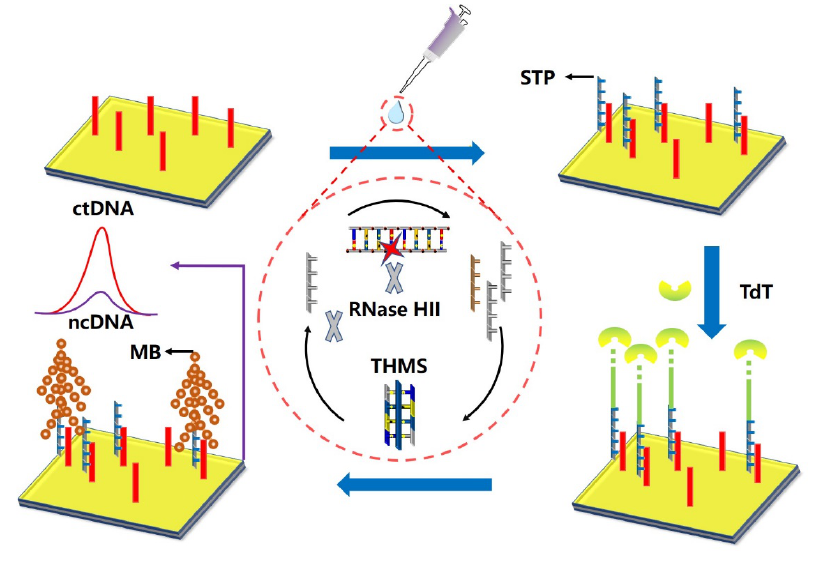
Figure 5. Schematic illustration of the enzyme biosensor using THMS probe and TdT and RNase HII dual amplification (Adapted with permission from Ref. [42]. 2018, Wang et al).